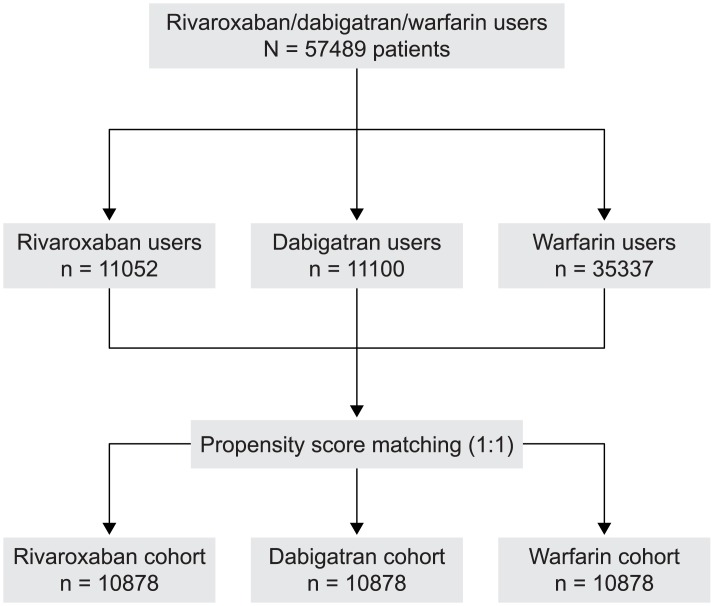
Patient flow diagram.